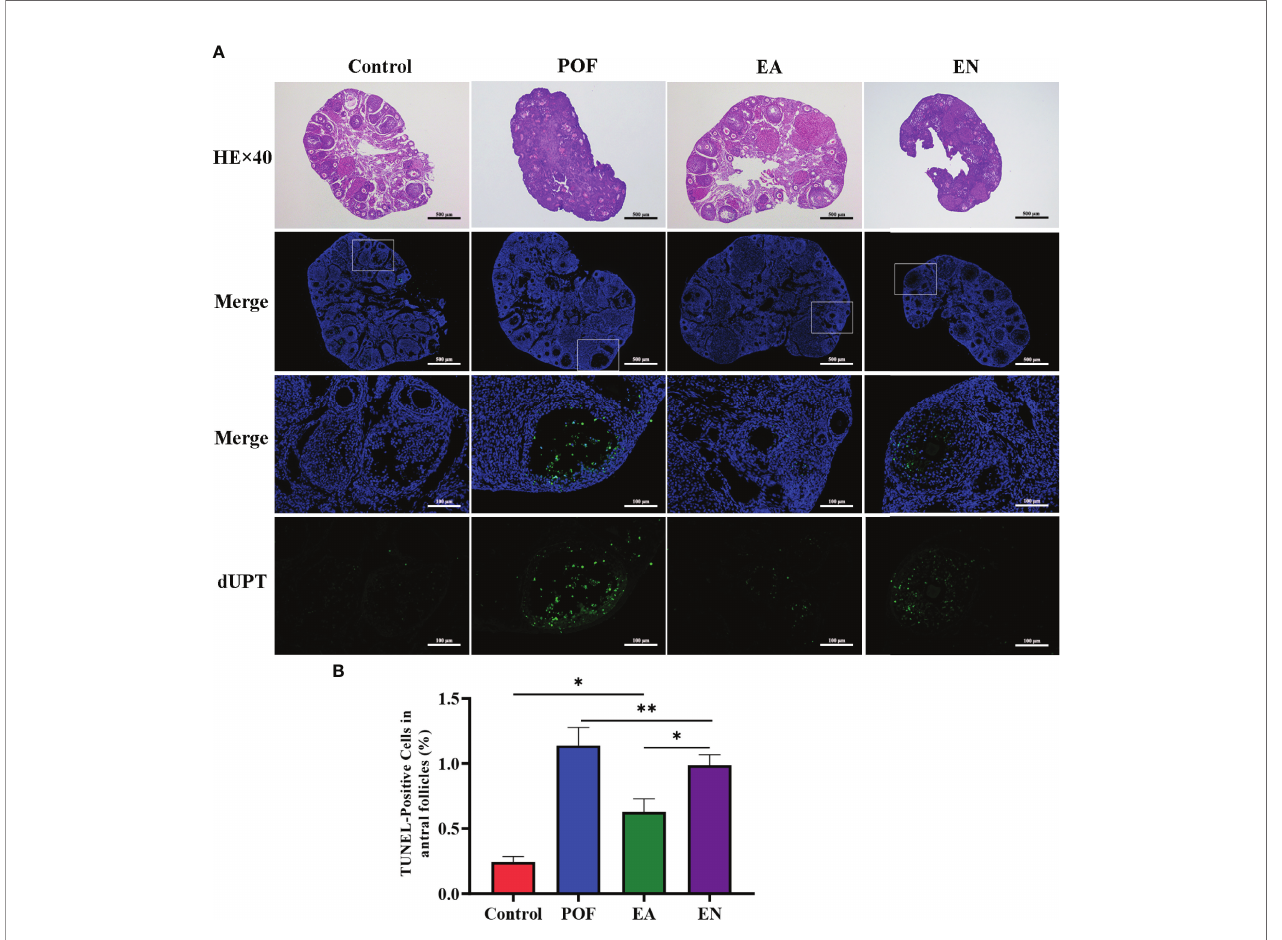
FIGURE 3 | Pathological morphology and granulosa cell apoptosis of ovaries in four groups (A) , HE staining and TUNEL detection; (B) , the positive rate of granulosa cell apoptosis in antral follicles) (×40 and ×200 magni fi cation; * means P < 0.05; ** means P <